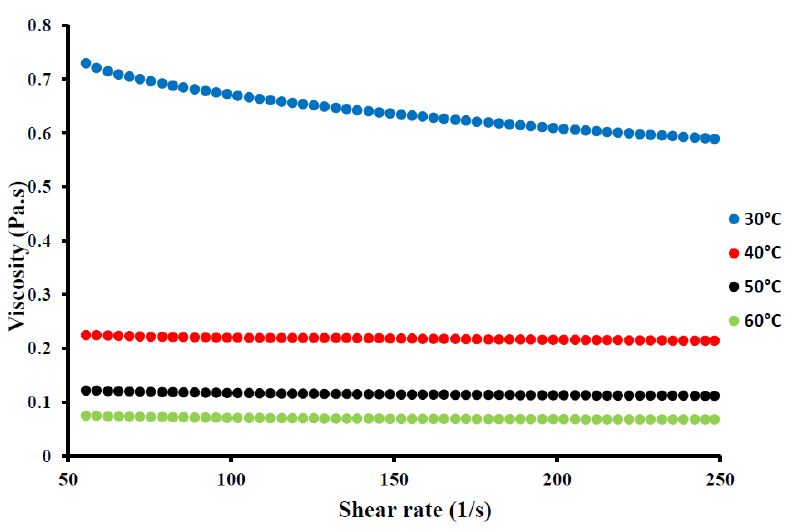
Figure 2. Impact of CTO temperature on the viscosity vs shear rate interaction.